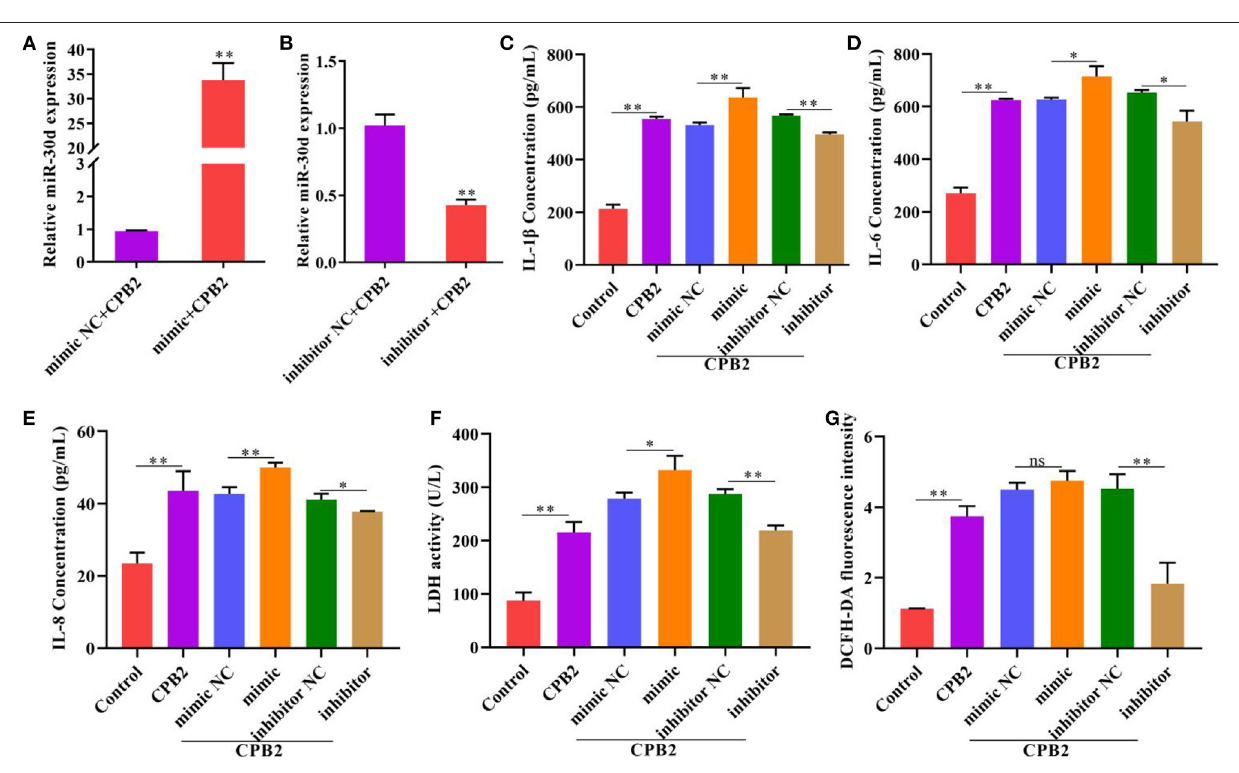
FIGURE 2 | Downregulation of miR-30d attenuated CPB2 toxin-induced inflammatory damage. IPEC-J2 cells were transfected with mimic NC, miR-30d mimic (50nM), inhibitor NC, and miR-30d inhibitor (150nM), and treated with CPB2 toxin. (A,B) miR-30d expression was detected at 36h after transfection by qPCR. (C–E) ELISA was performed to assess the levels of IL-1 β , IL-6, and IL-8 after transfection and treatment with CPB2 toxin for 36h. (F) LDH activity was detected at 450nm in a microplate reader. (G) The ROS level was evaluated by a microplate reader at 488-nm excitation wavelength and 535-nm emission wavelength. ns, not significant, * p < 0.05, ** p <